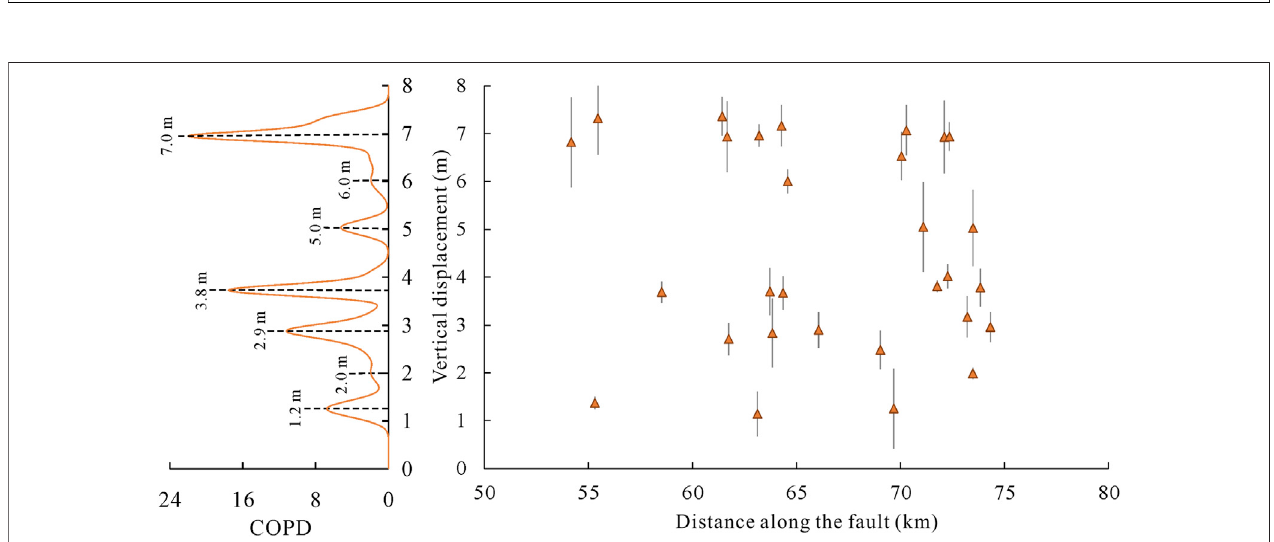
FIGURE9 | Statistical analysis ofthe verticaldisplacements on the Heshunzhuang-Baotou segment inthe range of0 – 8 m. Each displacement is represented bya Gaussian PDF. Adding up the PDFs of all displacements forms the COPD curve which generally shows several peak shapes, and each peak may indicate an individual